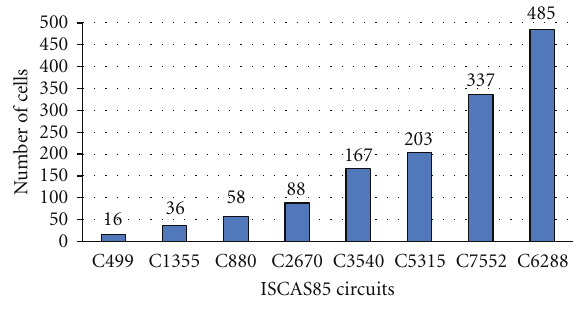
Figure 10: Total number of cells